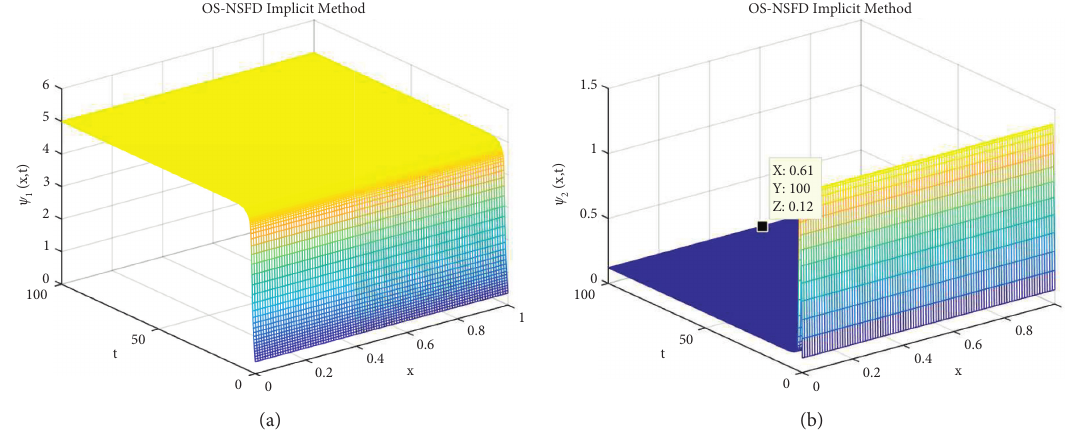
Figure 17: Mesh graphs of ψ Mesh graph of ψ